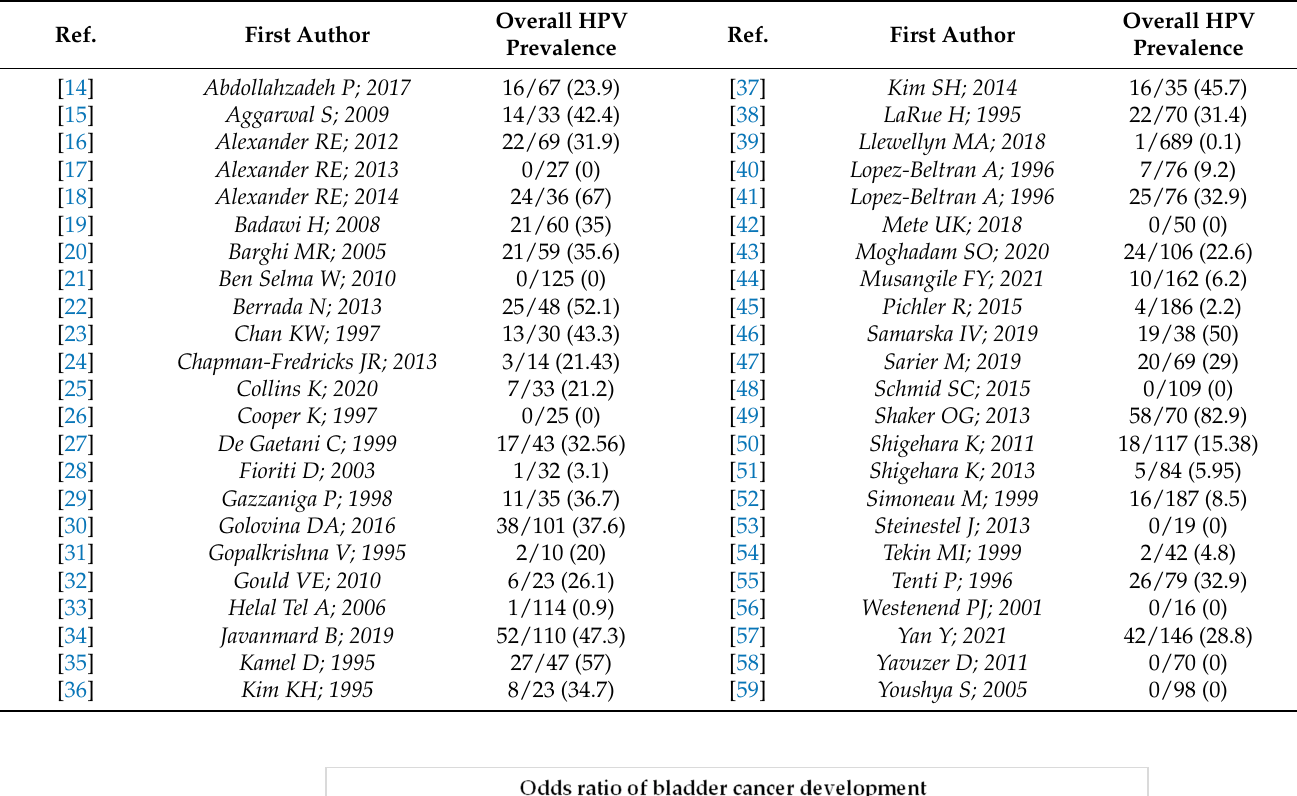
Table 4. Overall HPV prevalence among the selected studies. If different prevalence values were outlined in the studies, the value from the standard detection technique (or the highest in case of comparison between standard methods) was reported in the table below.